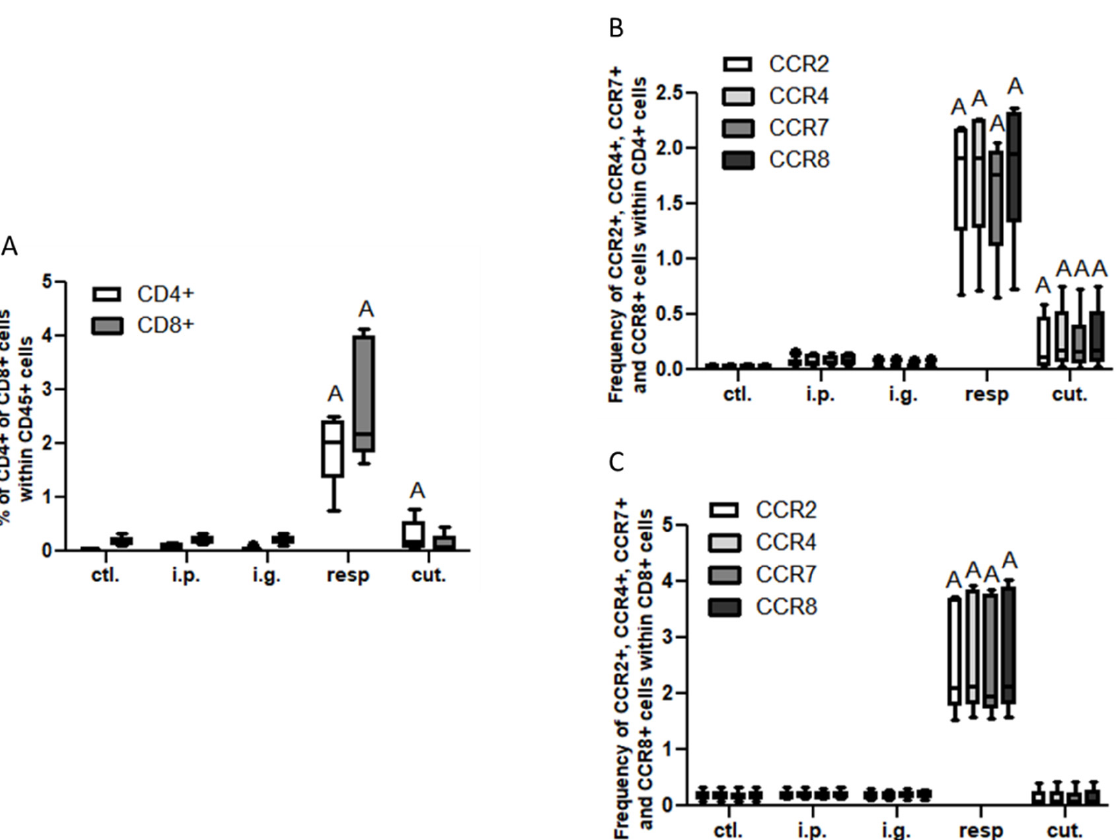
Figure 7. T cell influx in BAL : ( A ) Frequencies of T lymphocytes CD4 + (CD8 ₋ , empty bars) and CD8 + (CD4 ₋ , gray bars). Frequency of CCR2 + (empty bars), CCR4 + (light gray bars), CCR7 + (dark gray bars), and CCR8 + (black bars) within CD4 + ( B ) or within CD8 + ( C ) in BAL from mice exposed through the different routes. CD4 + and CD8 + cells were selected within CD45 + CD3 + gated cells. “A” indicates a significant difference between indicated group and control group ( p < 0.05 using non-parametric Kruskal–Wallis and Dunn’s post-Test).